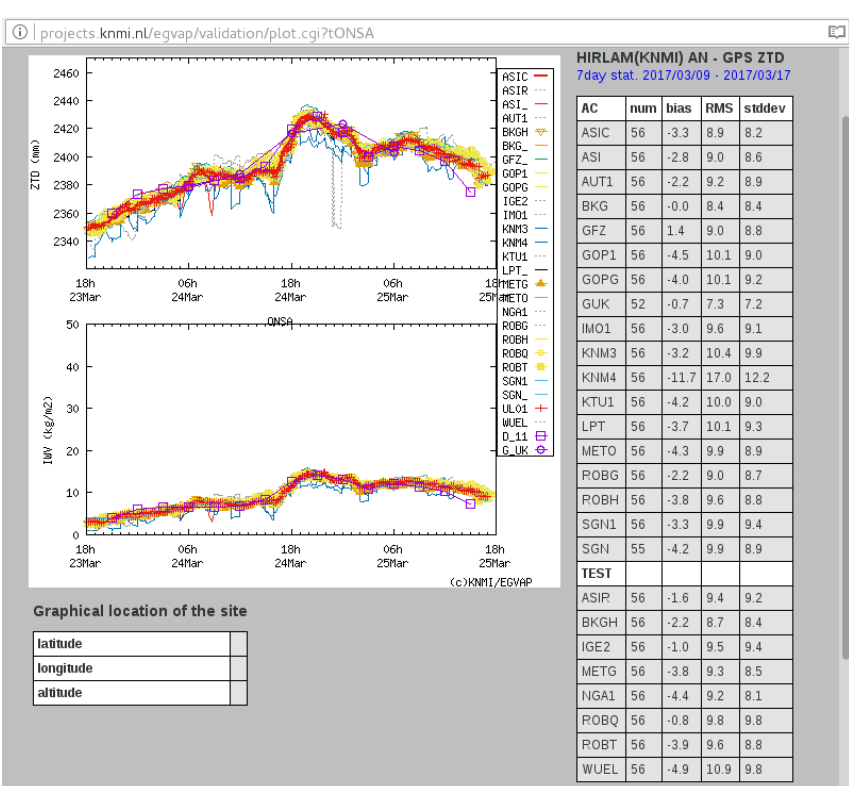
Figure 1. Example of validation of ZTD (upper panel) and integrated water vapour (lower panel) from a week in March 2017 for station Onsala, Sweden. Statistics for different processing centres compared to a NWP run are shown in the table. The data are taken from the E-GVAP